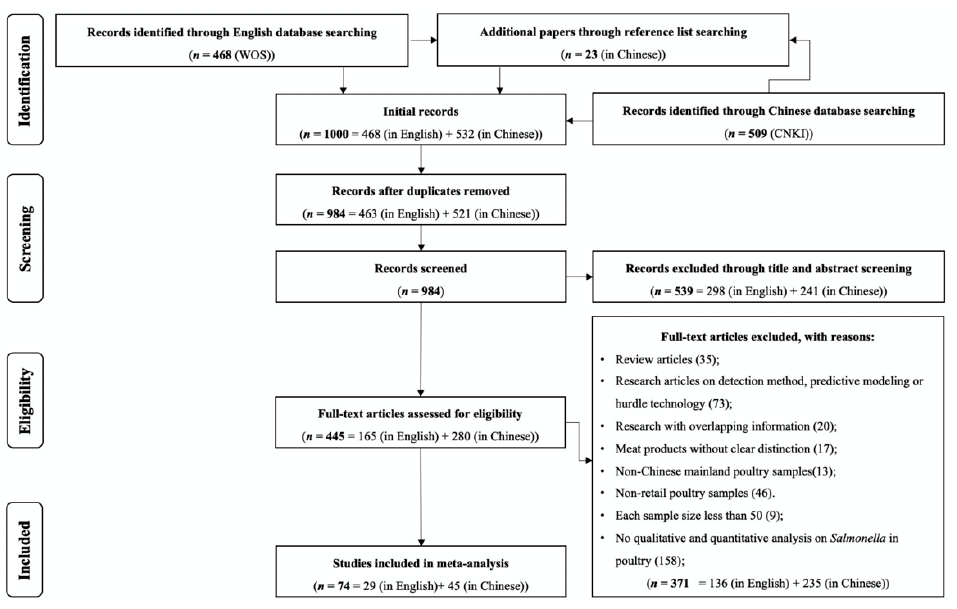
Figure 1. The flowchart of the literature searching and collecting.